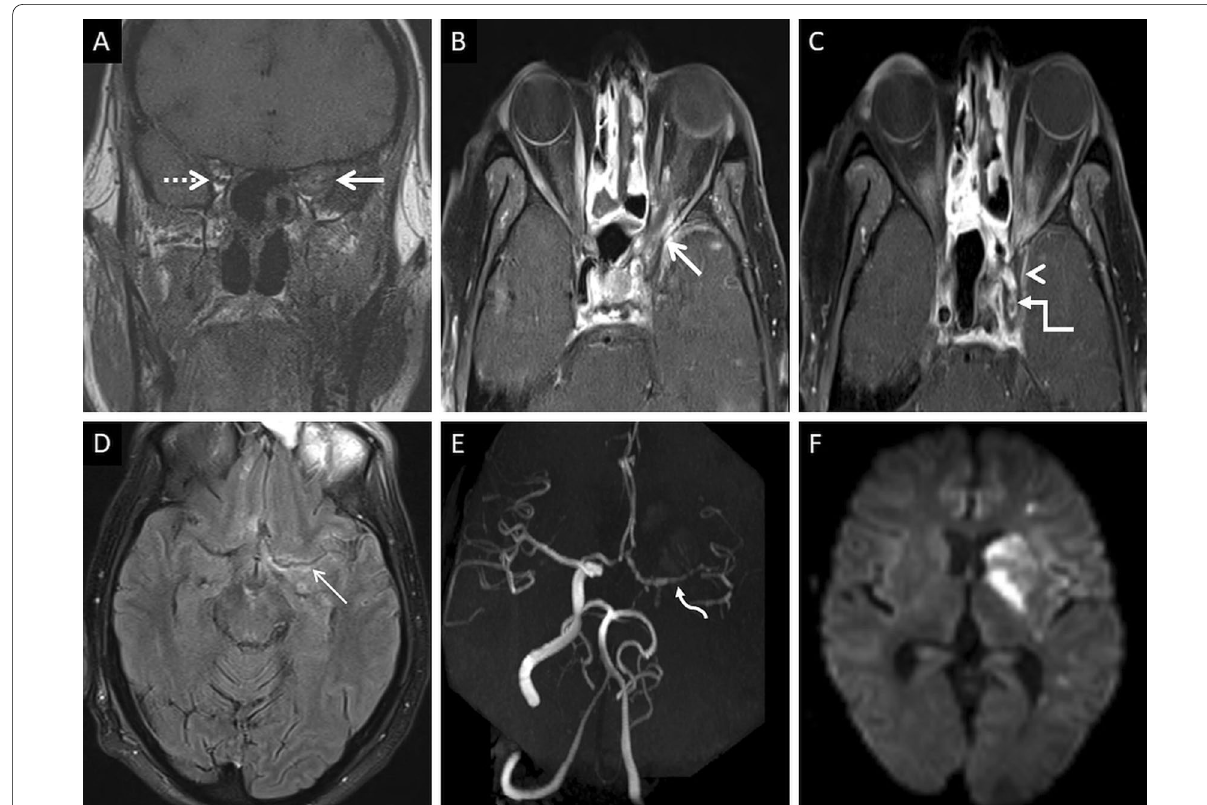
Fig. 17 Intracranial spread of ROCM in a patient with bilateral ethmoid sinus disease (not shown). Coronal T1W image ( a ) reveals abnormal soft tissue within the left orbital apex (thick arrow). Note the normal fat signals in the contralateral orbital apex (dotted arrow). CE FS axial T1W images ( b , c ) demonstrate the soft tissue in the left orbital apex (thick arrow in b ), non-enhancement of the left cavernous sinus (arrow head in c ) suggesting thrombosis, and loss of flow void along the left carotid siphon (stepped arrow in c ) representing occlusion. Axial CE FLAIR image ( d ) reveals leptomeningeal enhancement along the left middle cerebral artery sulcus (thin arrow). 3-D reconstruction of a Time-of-Flight MR angiogram ( e ) confirms the occlusion of the left internal carotid artery along with attenuated, irregular flow signals within the M1 segment of the middle cerebral artery (curved arrow), reformed via the circle of Willis, and reduced distal cortical arborisation. Diffusion weighted image ( f ) demonstrates scattered acute infarcts in the left middle cerebral artery territory. In summary, the diagnosis of ROCM with orbital apex involvement and intracranial spread (cavernous sinus thrombosis, leptomeningeal disease and MCR-related vasculitis) was